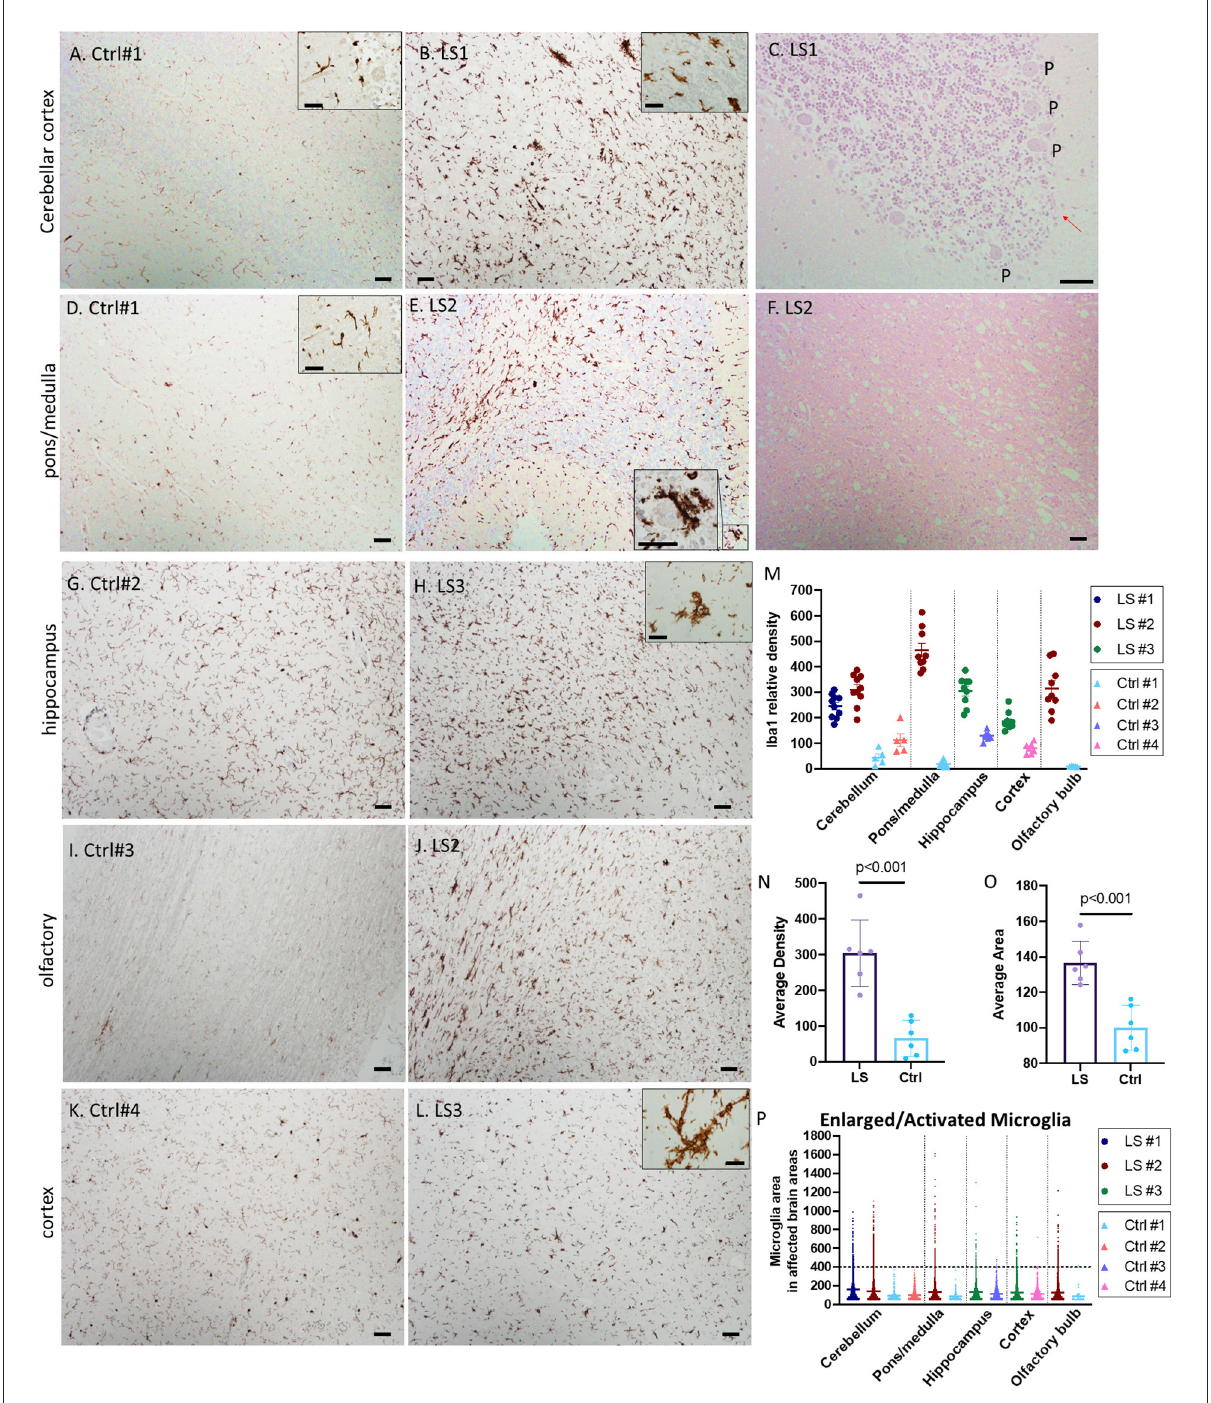
FIGURE2 (A–F) Representative IHC for Iba1 and corresponding H&E staining of Leigh syndrome cerebellum and pons/medulla. Compared with controls (A, D) , there is substantial increase in microglia indicated by Iba1 staining in the LS cerebellar pons (B) and cortex (E) . High magnification of Iba1 + activated microglia’s cytoplasm partially surrounding a Purkinje neuron ( E , inset) and the corresponding area displayed the loss of Purkinje (P) neurons [ (C) , red arrow]. (F) The corresponding H&E staining of LS pons from (E) showed neuropil vacuolization. (G–L) Representative IHC for Iba1 of hippocampus, olfactory and cerebral cortex in control brains (left panels) vs. brains from Leigh syndrome patients (LS2,3, right panels). Compared with controls, there is substantial increase in microglia marked by Iba1 staining. Multiple affected regions of brains from three LS patients and controls were analyzed. (M) Relative densities of Iba1 + cells in various affected brain regions. (N) Analysis of all data from multiple regions of LS vs. controls. (O, P) Cell size of Iba1 + microglia showed several enlarged activated microglia in LS brains; 5–10 images from multiple regions of brains from three LS patients and four controls were analyzed. Scale bar: 50 µ m. Inset scale: 25 µ